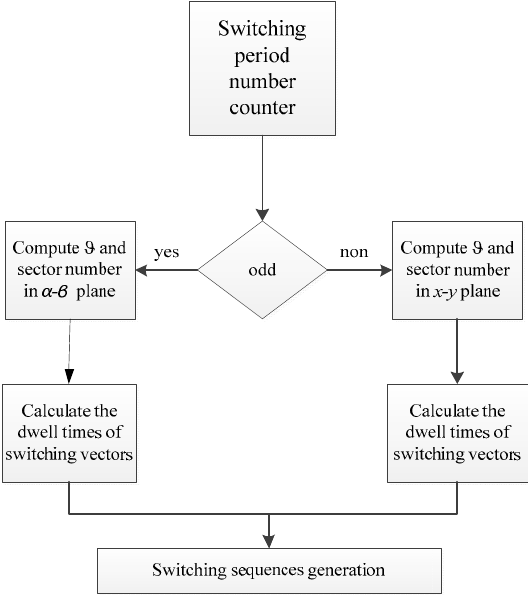
Figure 5. Steps of SVM technique for parallel connected two-machine drive. Electronics 2018 , 7 , x FOR PEER REVIEW 11 of 19 Sector s = 1 ( α - β ) Sector s = 3 ( x - y )